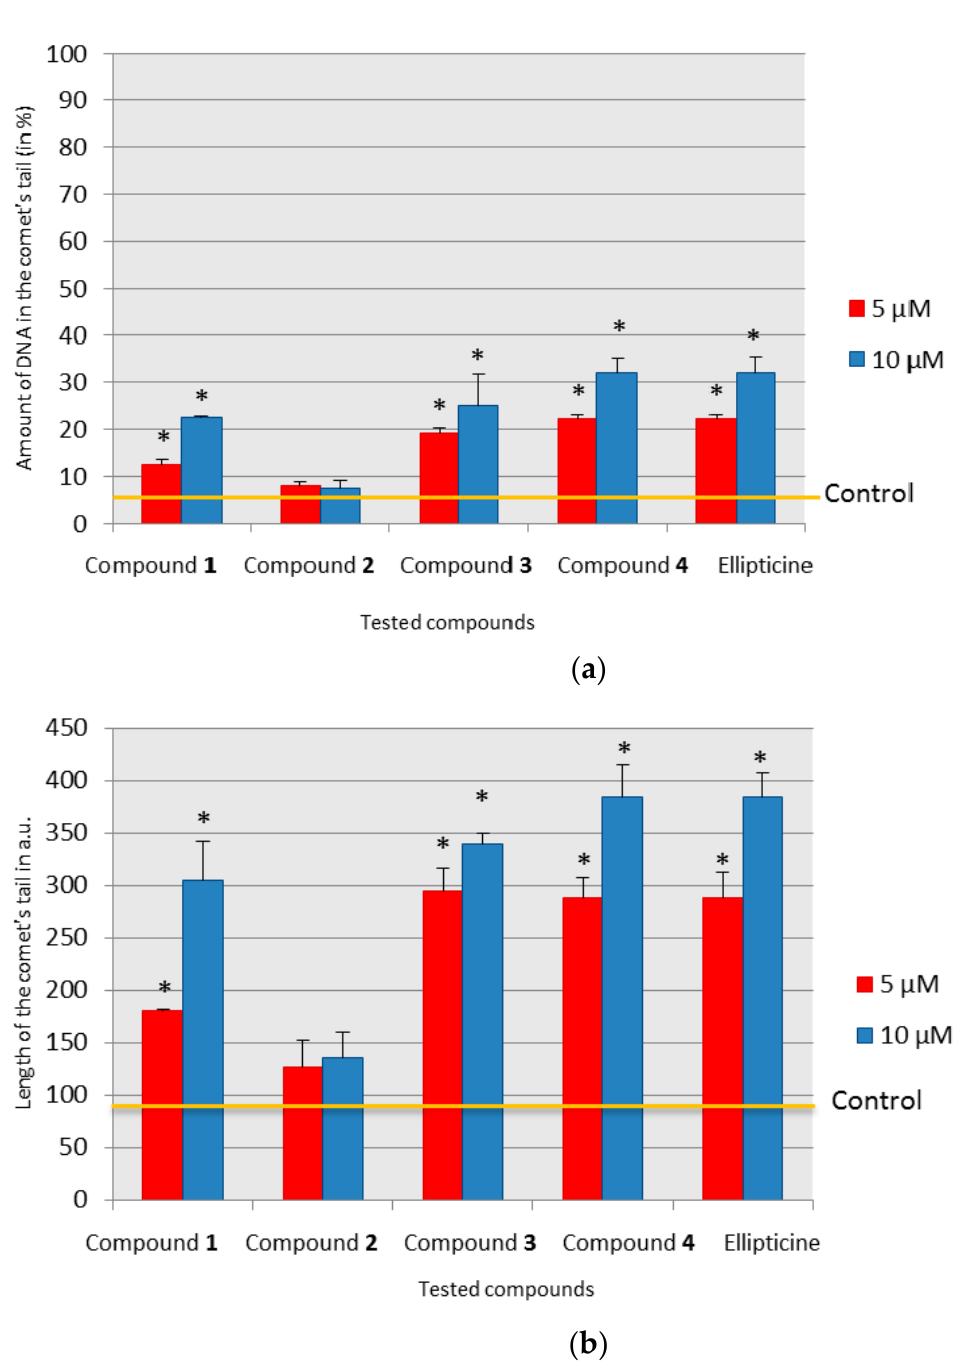
Figure 4. Evaluation of direct genotoxicity in a comet test; * p ≤ 0.05. ( a ) The figure shows the amount of DNA in the comet’s tail (in %). Control value indicated by yellow line: 5.42 ( ± 1.33). ( b ) The figure shows the length of the comet’s tail in arbitrary units (a.u.). Control value indicated by yellow line: 88.2 (±4.6) .